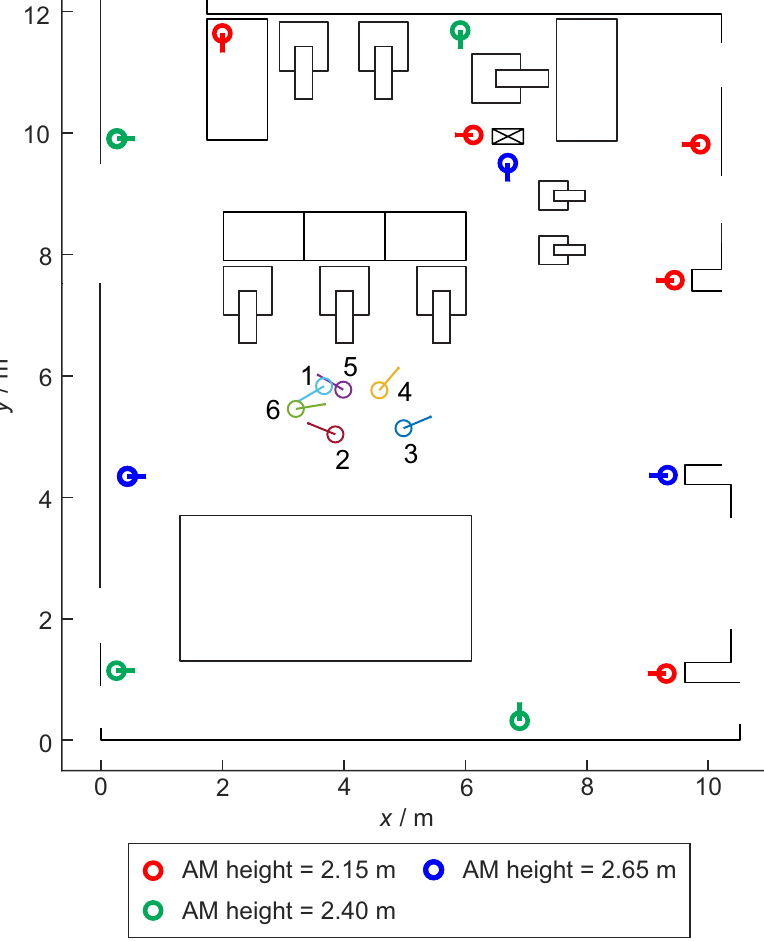
Figure 7. Real-time localization system (RTLS) setup in the laboratory with 12 anchors and 6 tag poses. The position for each pose is represented by a circle and the orientation with a short line. The short line represents the UWB zero-degree orientation. The same is valid for the anchors. The additional elements in the figure are other objects in the laboratory. AM heights in the legend describe the height of the anchor from the